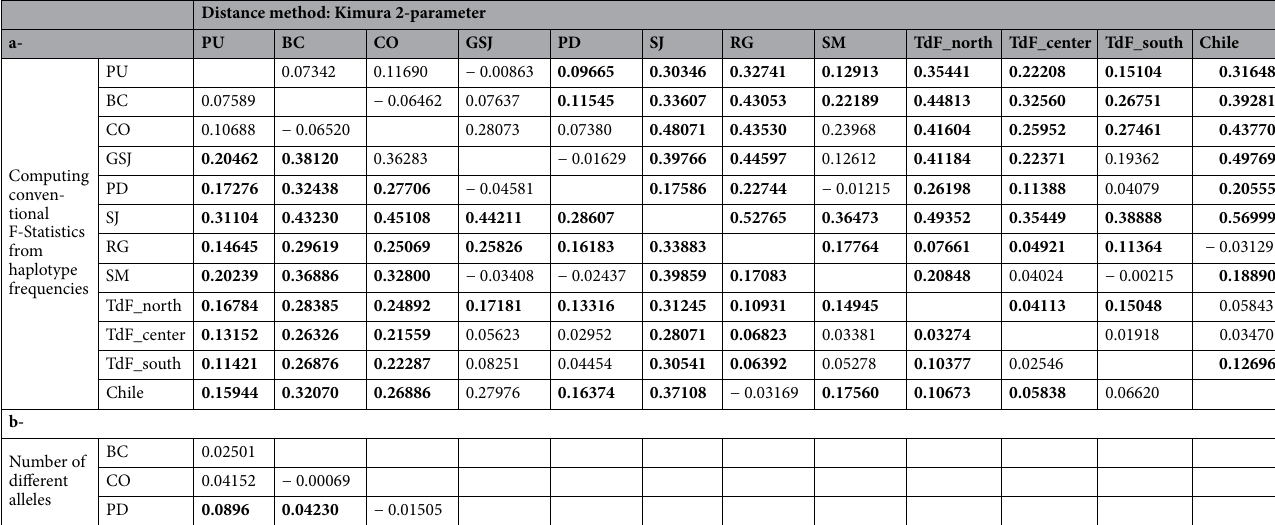
Table 3. Genetic differentiation among pairwise populations of Commerson’s dolphin ( Cephalorhynchus commersonii ) using: a- mitochondrial DNA control region (423 bp) of all distribution (F ST values are reported below the diagonal, whereas Φ ST values are reported above the diagonal). b- 28 microsatellites loci in 50 individuals. Significant values (α = 0.05) are in bold font. PU = Playa Unión, BC = Bahía Camarones, CO = Caleta Olivia, GSJ = Golfo San José, PD = Puerto Deseado, SJ = San Julián, RG = Río Gallegos, SM = Strait of Magellan, TdF = Tierra del